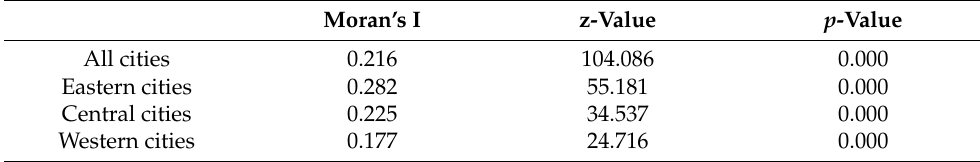
Table 4. Spatial autocorrelation